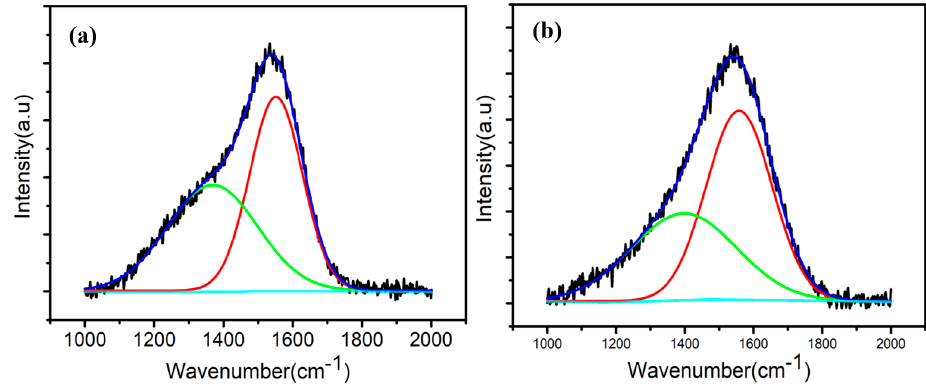
Figure 3. Raman spectra: ( a ) a-C:H samples, ( b ) a-C samples.